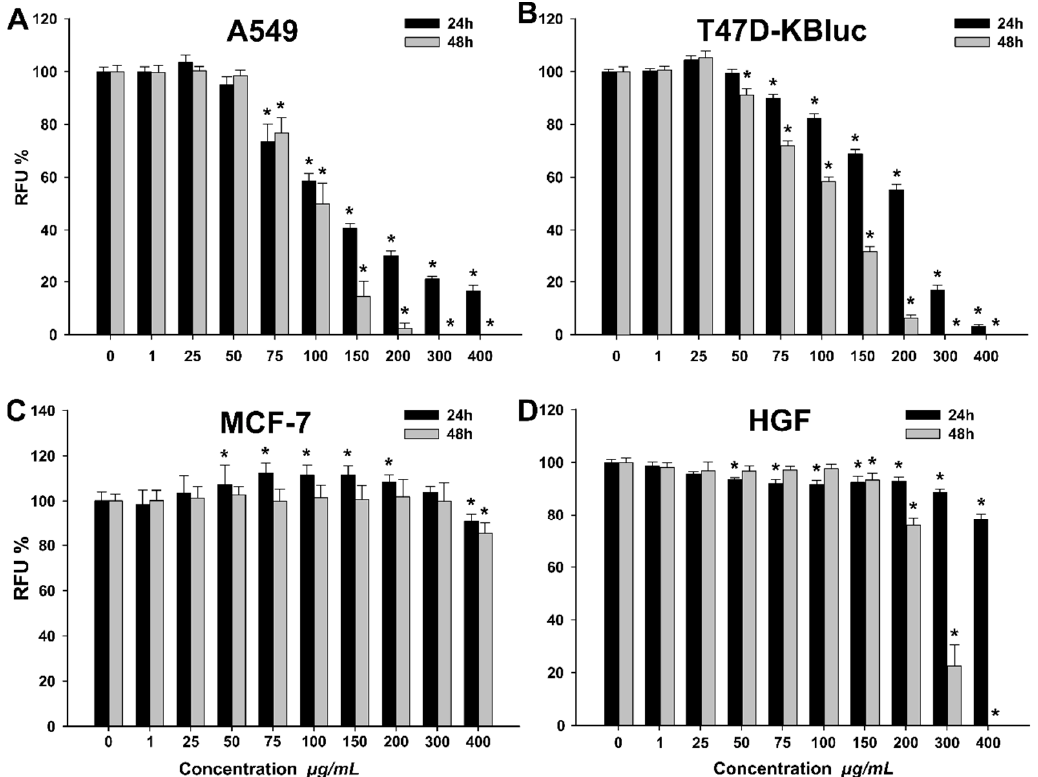
Figure 2. Cytotoxic effect of the septum extract observed using Alamar Blue assay on A549 ( A ), T47D-KBluc ( B ), MCF-7( C ) and human gingival fibroblasts (HGF) ( D ). The results are expressed as relative means ± standard deviations (six technical replicates for each of the three biological replicates) where the negative control (DMSO 0.2%) is 100%. Asterisks (*) indicate significant di ff erences ( p < 0.05) compared to the negative control. RFU— relative fluorescence units.